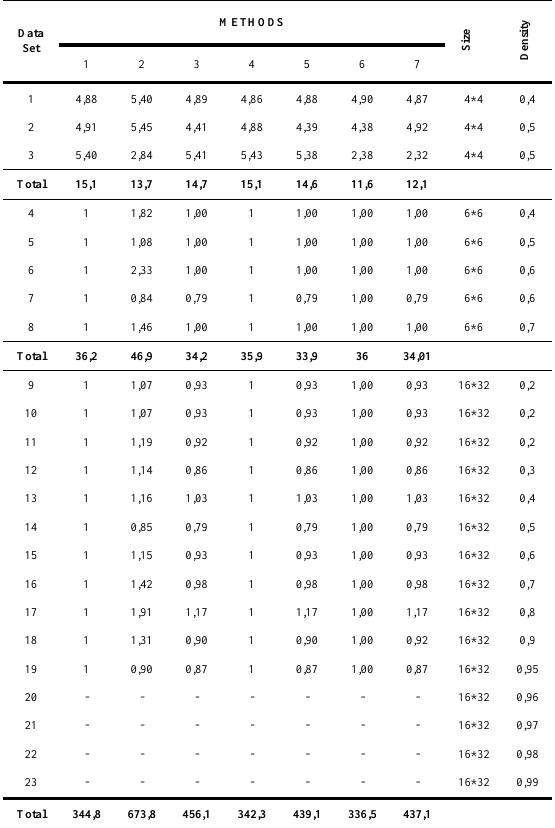
Table 5. Solution times of the methods